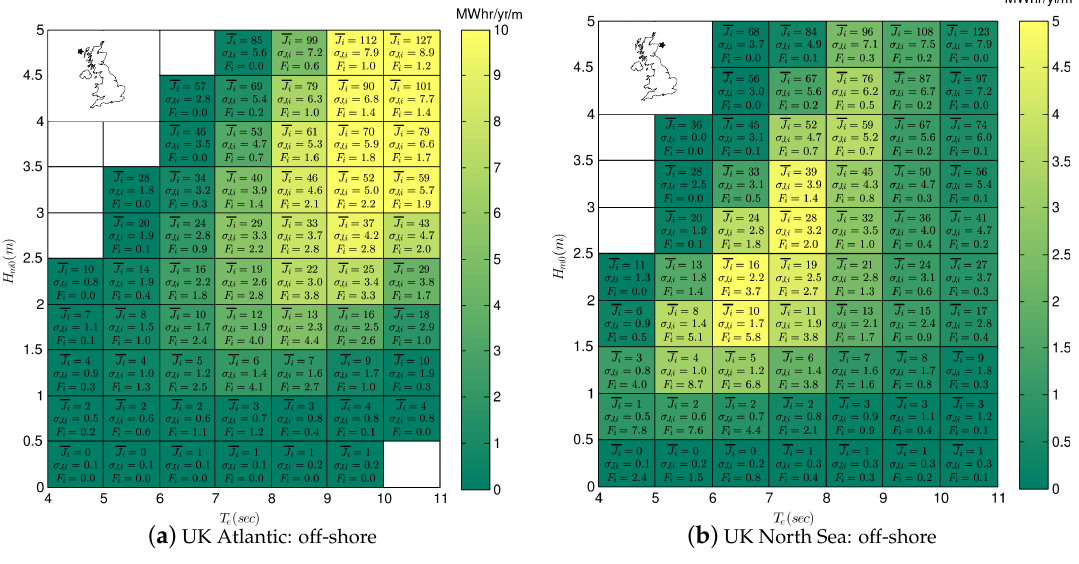
Figure 4. Wave matrices for UK offshore sites. Text indicates mean and standard deviation of wave power ( J i , σ J , i , in kW/m) and frequency of occurrence ( F i as a percentage). Color indicates average wave energy in